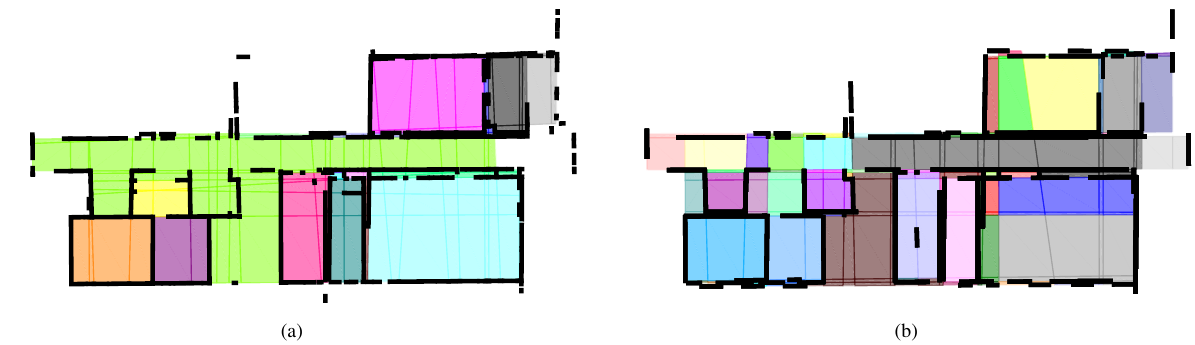
Figure 10. Dataset TUB2 (second floor): floor plans obtained with (a) the proposed method and (b) the method by (Magri and Fusiello, 2018). This figure is best viewed in colours.